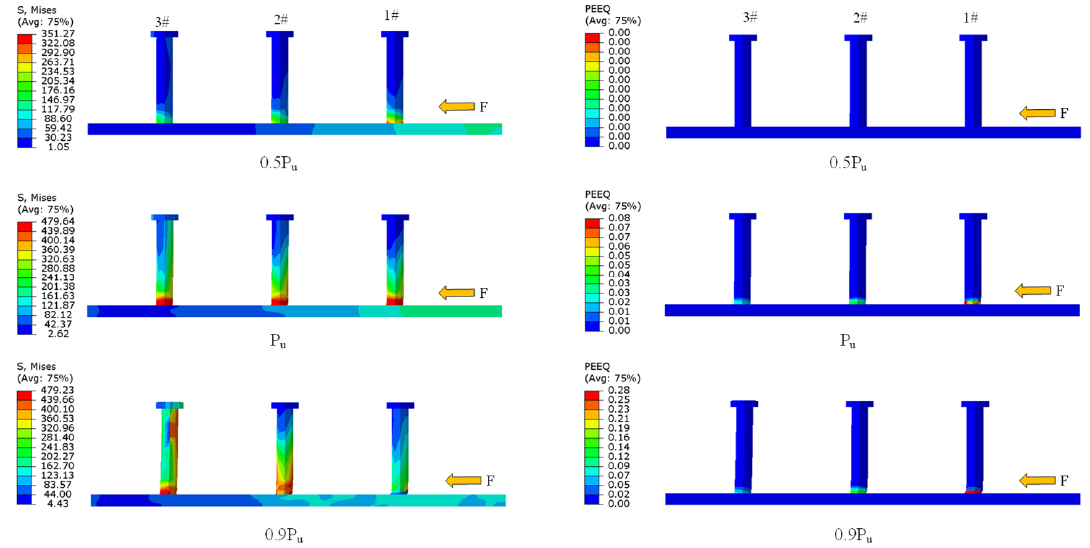
Figure 15. Contour plots of Mises stress, PEEQ for studs.